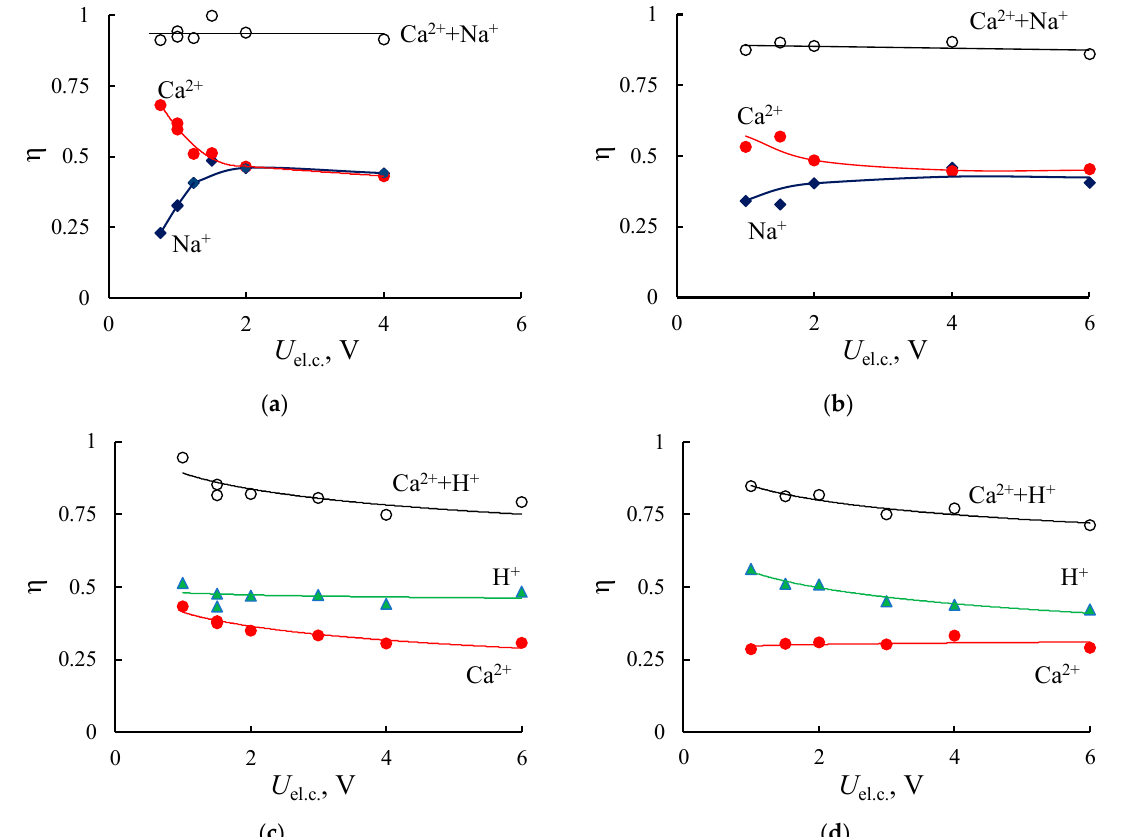
Figure 10. Current efficiency for the electrodialysis processing of NaCl + CaCl 2 ( a , b ) and HCl + CaCl 2 ( c , d ) solutions with the initial MK-40 ( a , c ) and composite MK-40/PANI ( b , d ) membranes.